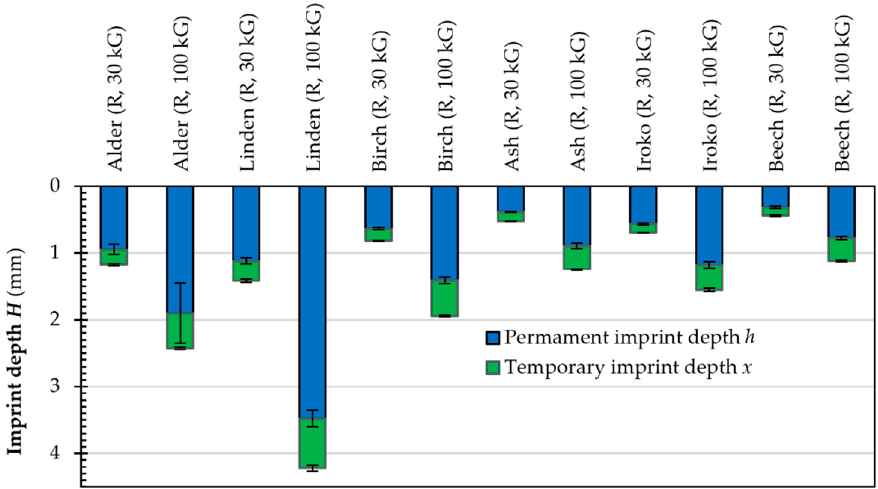
Figure 7. Imprint depth under measuring load (radial direction).